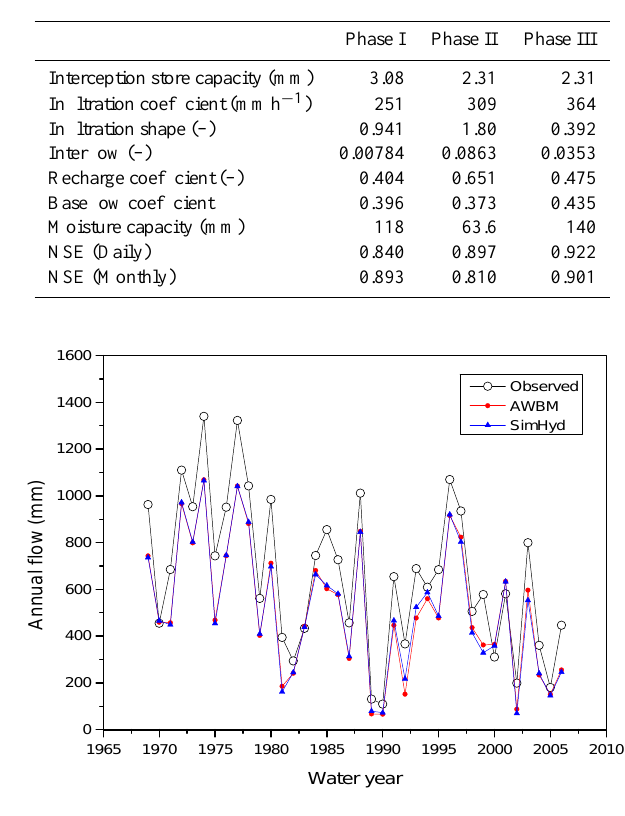
Table 2. Calibrated parameter values using SimHyd for each of the three phases for the Rimbaud watershed in France.